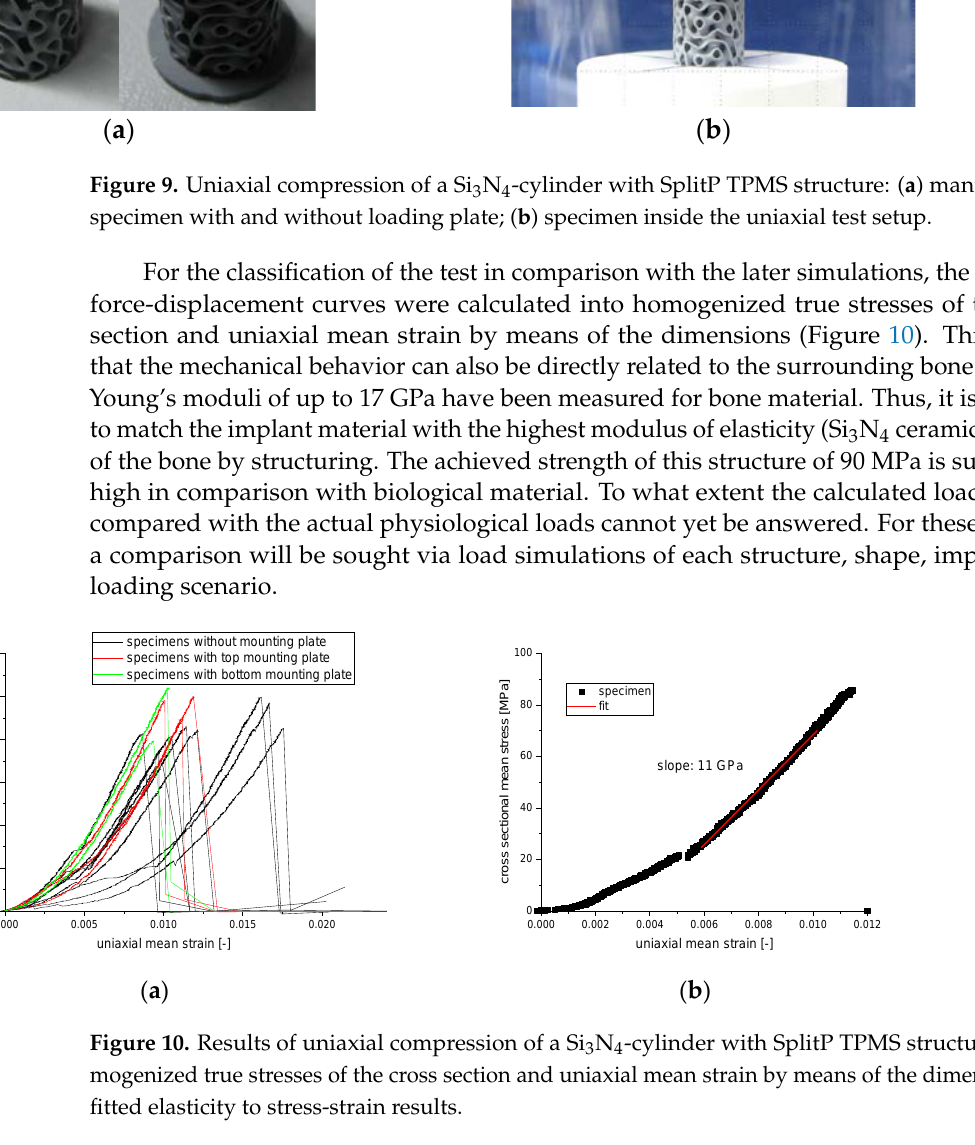
( b ) Figure 11. Ball-on-three-balls test: ( a ) test geometry for cylindric plates with and without top layer; ( b ) maximal principal stress for cut view of loaded cylinder Since the internal load in the B3B test is not linearly coupled with geometric param- eters, the effective volume must be provided not only as a function of the Weibull modu- lus m , but also as a function of the generated stress F/t 2 for the specific geometry (Figure 12).